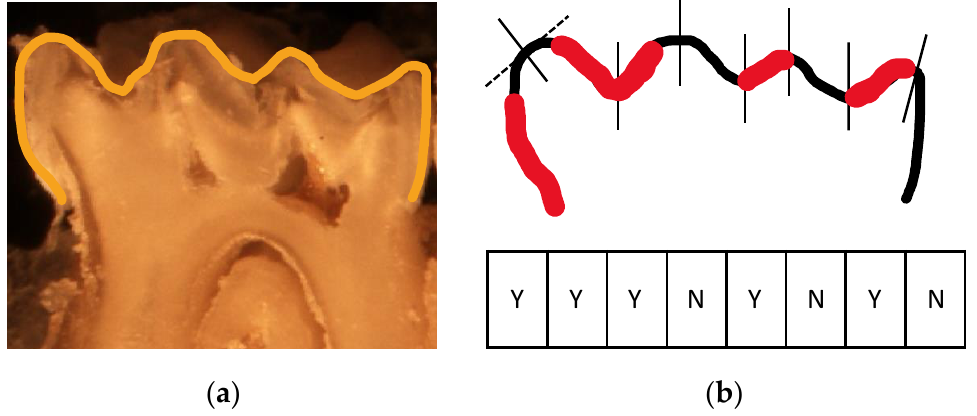
Figure 3. Caries scoring using hemi-sectioned molars. First mandibular molars were hemi-sectioned along the mesiodistal plane and photographed using an SMZ25 stereoscope. ( a ) Representative hemi-section of caries-infected mandibular molar with marked occlusal surface outline. ( b ) Occlusal surface was divided into eight surfaces; a vertical tangent for the tip of each cusp and the depth of each fissure was marked. The verticals divided the occlusal surface into eight units. Each unit was marked using the table below: Y = Caries was detected, N = No caries was detected. The units identified as caries infected were marked in red and were summed to numeric score.